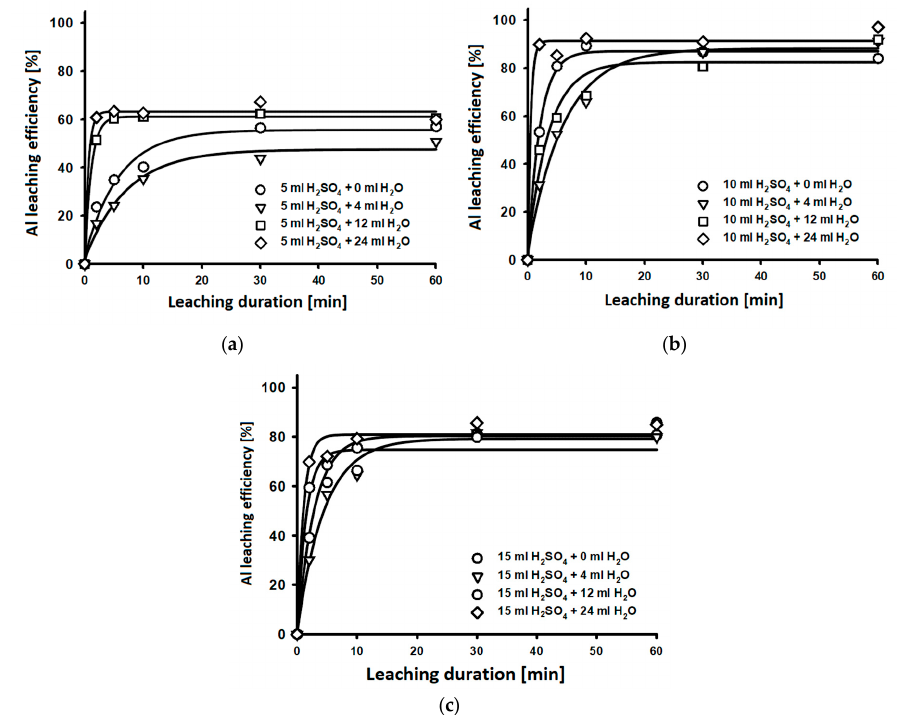
Figure 16. Lithium leaching efficiency in H 2 O using ( a ) 5 mL of H 2 SO 4 , ( b ) 10 mL of H 2 SO 4 , ( c ) 15 mL of H 2 SO 4 .